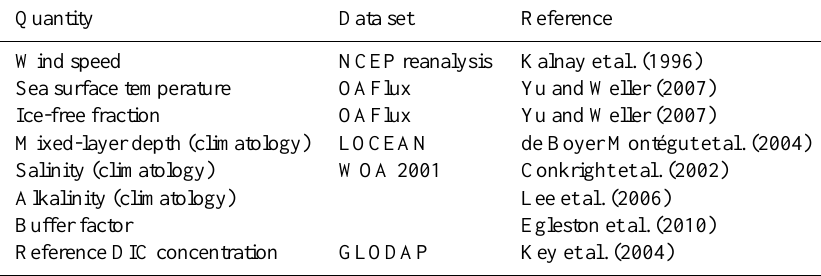
Table 1. Data sets used as driver fields in the parameterizations of sea–air gas exchange, solubility, and carbonate chemistry (see Rödenbeck et al., 2013).